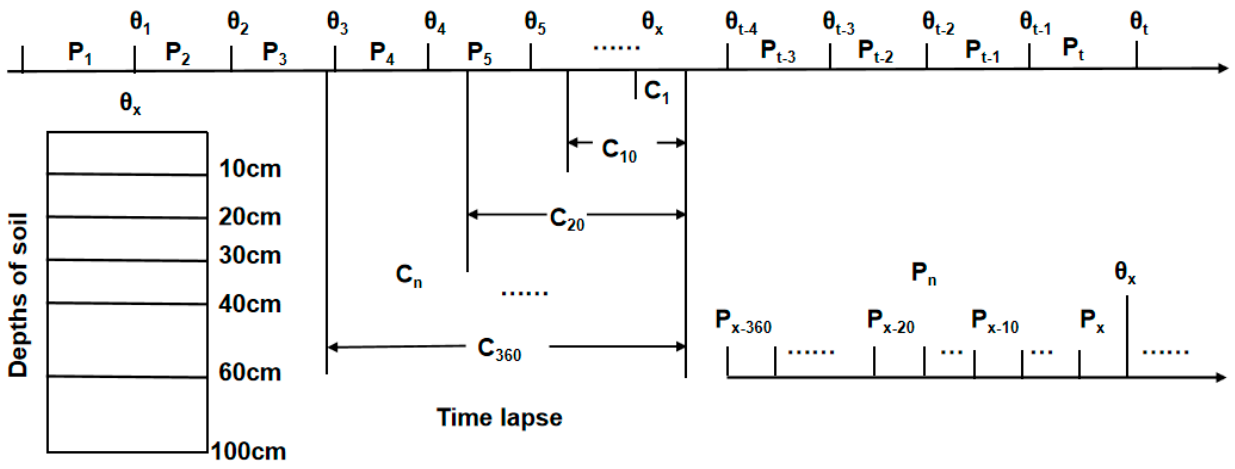
Figure 2. Time series of soil moisture from θ 1 to θ t; θ x is soil moisture at time x and it is measured at different soil depths; Pn is every day precipitation; and Cn is cumulative precipitation during n days before test.